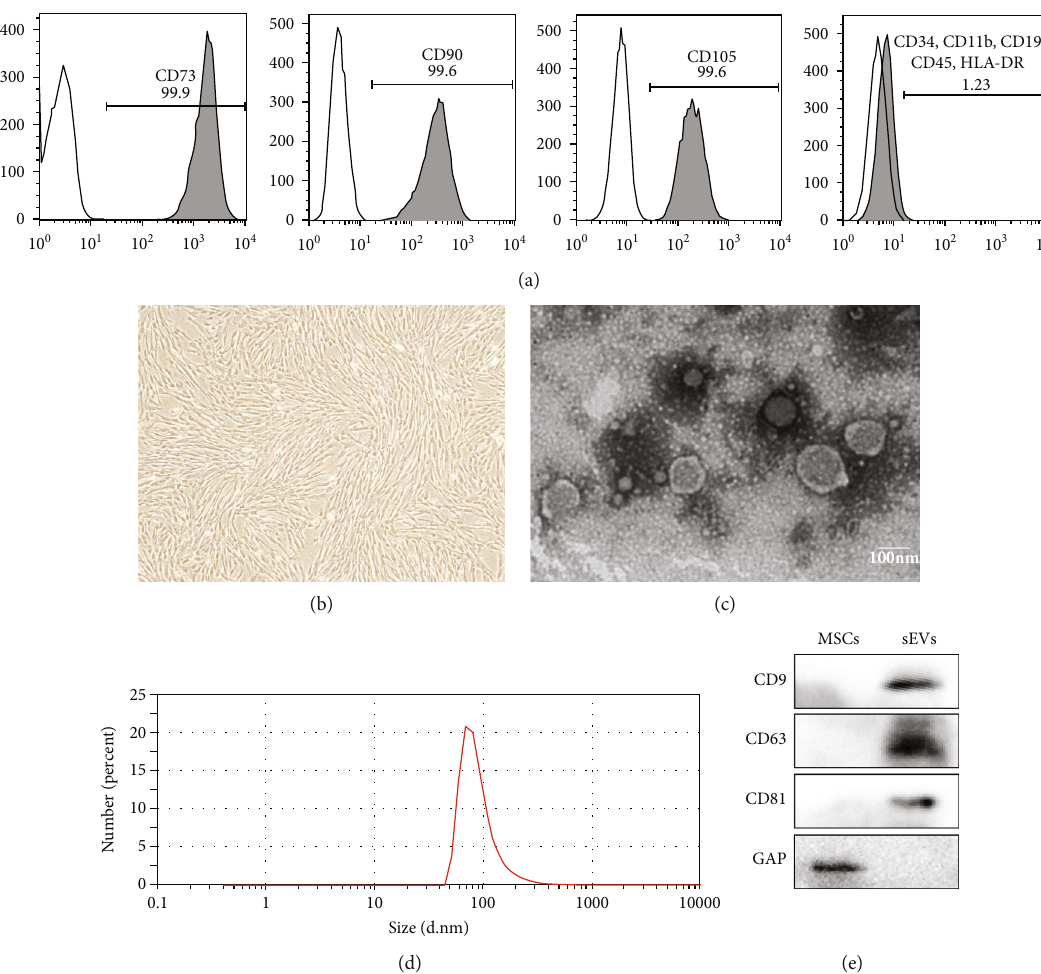
Figure 1: Morphological observation and identi fi cation of HUMSCs and HUMSC-sEVs. (a) Flow cytometry analysis of surface markers in HUMSCs. (b) Light morphology image of HUMSCs. (c) Morphology of HUMSC-sEVs under TEM. Scale bar, 100nm. (d) Peak size of HUMSC-sEVs was around 80nm as showed by NTA. (e) HUMSC-sEVs were positive for CD9, CD81, and CD63 as indicated by Western